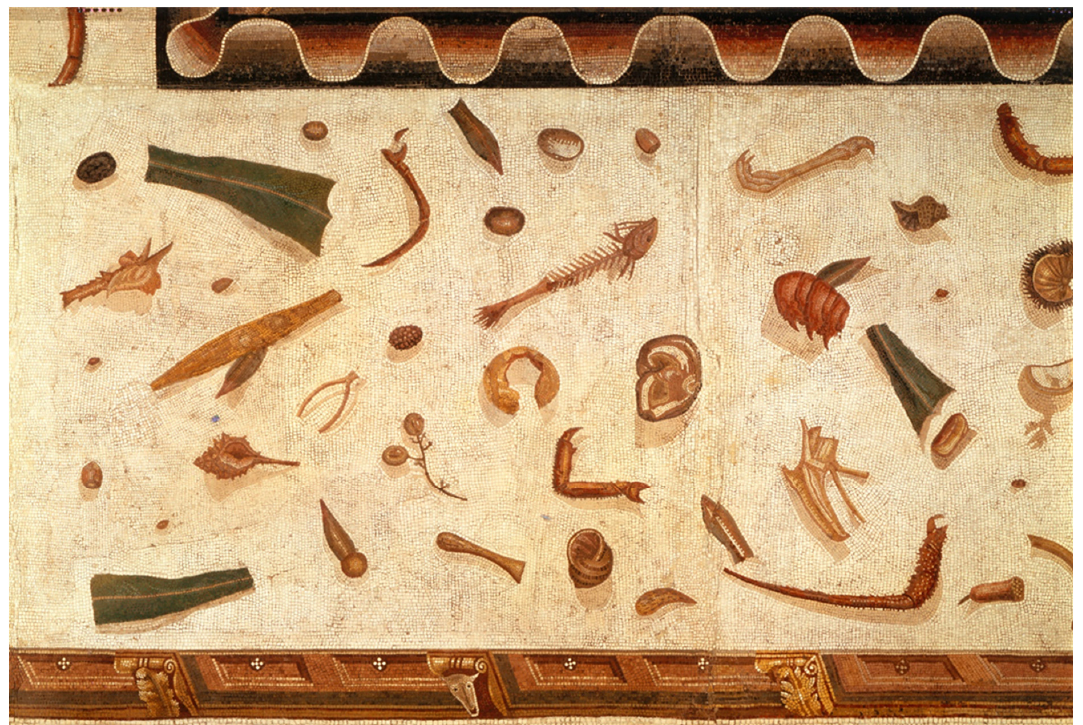
Figure 19. Signed by Heraklitos, detail of mosaic depicting ‘unswept floor’ ( asàrotos òikos ), 2nd century CE. Musei Vaticani, Museo Gregoriano Profano, 10132. Photo Credit: Scala/Art Resource, NY.